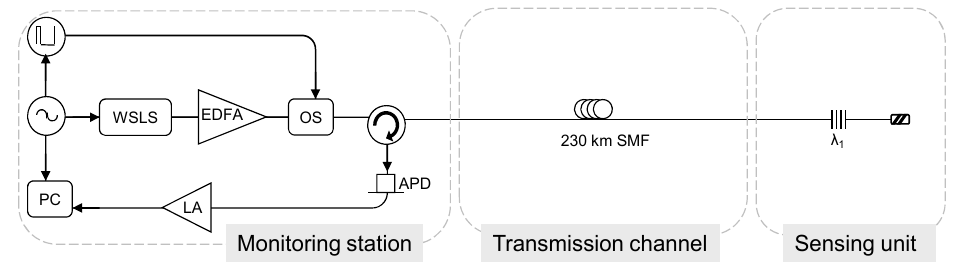
Figure 11. Experimental set-up for the FBG sensor system. APD: avalanche photodetector. L.A.: logarithmic amplifier. WSLS: wavelength-swept light source. OS: Optical switch. Adapted from